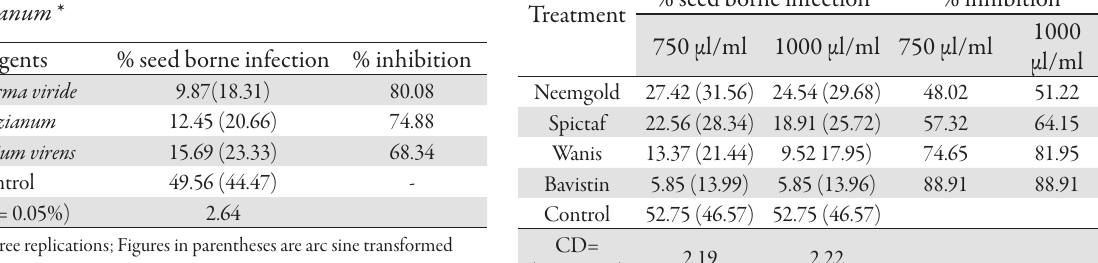
Fig. 2. Effect of biopesticides on mycelial growth of C. lindemuthianum Tab. 2. Effect of biopesticides on seed borne infection of Tab. 1. Effect of bioagents on seed borne infection of C.